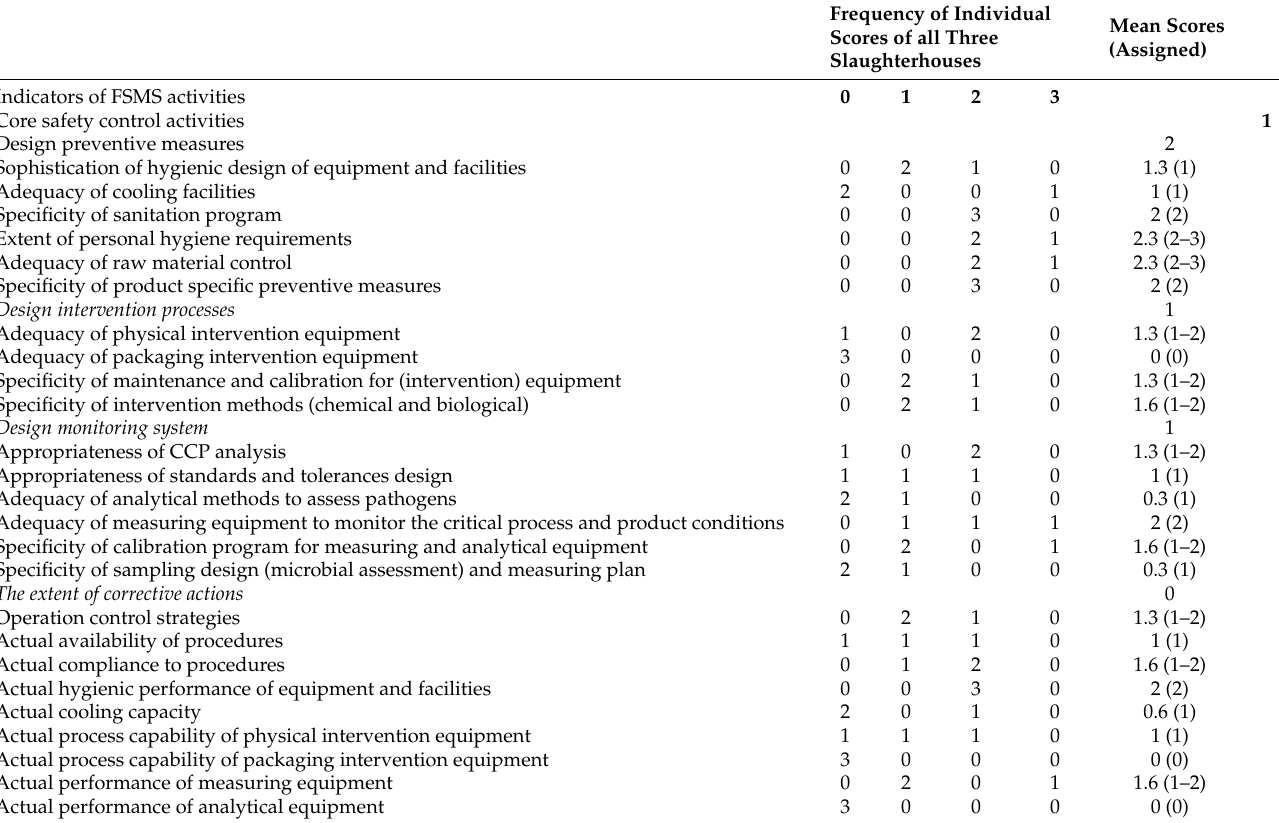
Table 1. Analysis of the core control FSMS activities at the three largest slaughterhouses in Kampala.